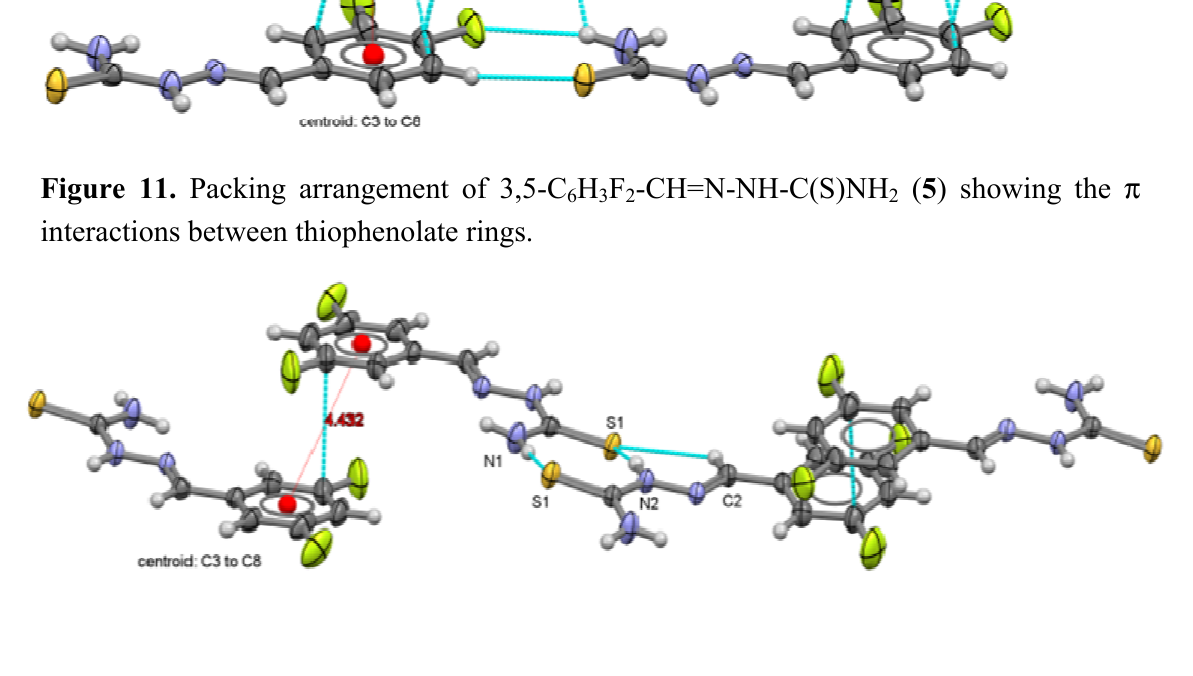
H F -CH=N-NH-C(S)NH 6 3 2